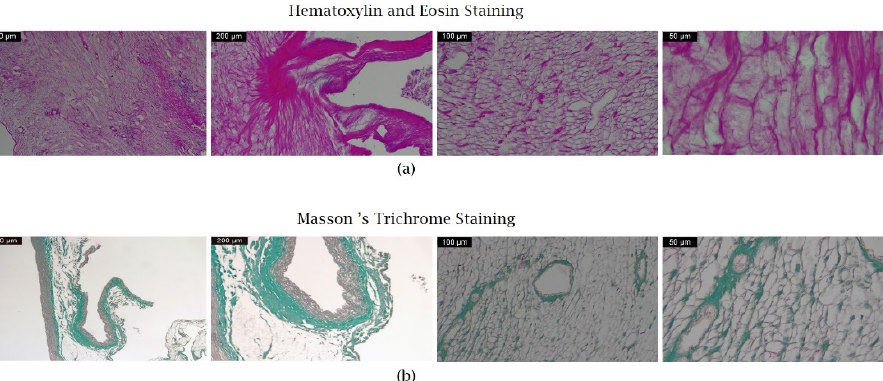
Figure 11 . ( a ) Representative H&E staining showing cardiac scaffold of a decellularized whole heart. The ECM remains unaffected. Please note that no nuclei or cellular remnants can be detected (Ob 4×, 10×, 20×, respectively 40×). ( b ) Representative Masson’s Trichrome staining showing preserved collagen and clearance of nuclei (Ob 4×, 10×, 20× respectively 40×).